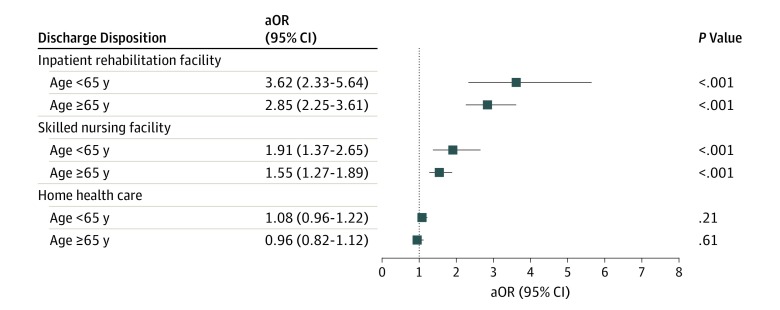
Association of Discharge Destination With Hospital Readmission Within 90 Days Stratified by Age Adjusted odds ratios (aORs) were calculated with home self-care as the reference category and adjusted for age, sex, insurance type, comorbidities, metropolitan area location, hospital annual total knee arthroplasty volume, and comorbidities (except for female sex, metropolitan area location, total knee arthroplasty volume by quarter, postoperative myocardial infarction, valvular disease, hypothyroid disease, and peptic ulcer disease in patients aged <65 years and total knee arthroplasty volume by quarter, prosthetic device complication, hypertension, hypothyroid disease, and solid tumor without metastasis in patients aged ≥65 years because these variables had P values >.10). Squares indicate point estimates; bars, 95% CI.